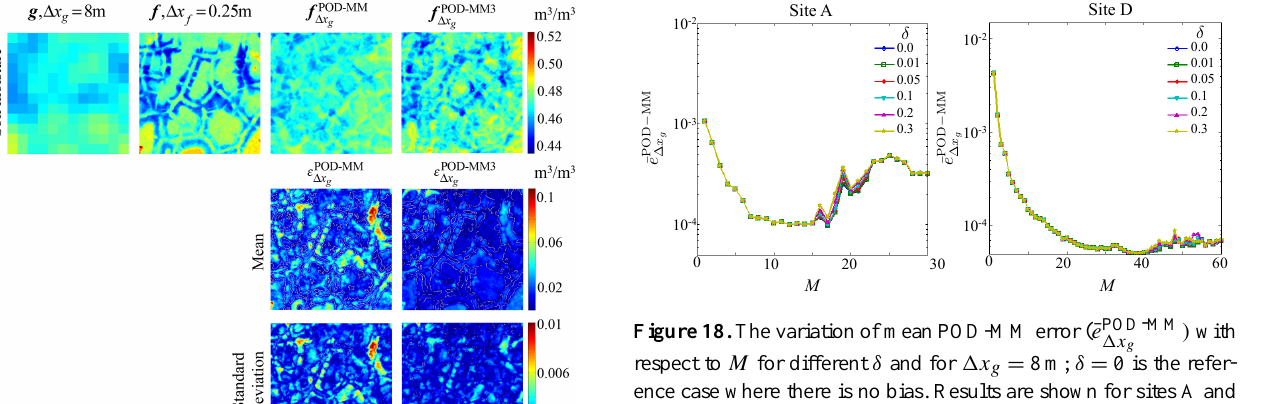
Figure 18. The variation of mean POD-MM error ( ¯ e POD - MM respect to M for different δ and for 1x g = 8m; δ = 0 is the refer- ence case where there is no bias. Results are shown for sites A and D for the year Figure 17. The top row shows the 20–25cm layer solutions of g , f , f POD - MM and f POD - MM3 for day 20 for year 1998 at 1x g 1x g site A for which e POD - MM3 is approximately equal to ¯ e POD - MM3 ; 1x g 1x g 1x g = 8m. The second and third rows show the mean and stan- dard deviation of ε POD - MM and ε POD - MM3 for the 20–25cm layer 1x g 1x g computed over 1998, 1999, 2000, 2002, and 2006. f POD - mean , since f POD - mean 1x g 1x g